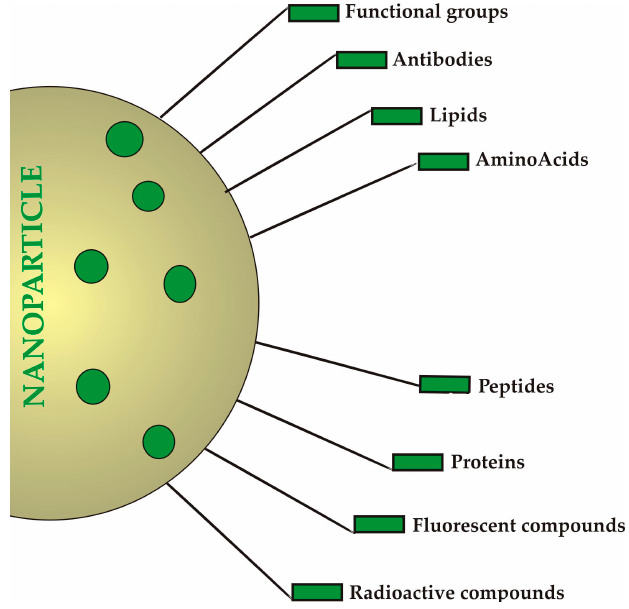
Figure 6. Different approaches to modify surfaces of nanoparticles (NPs) to target cancer cells.